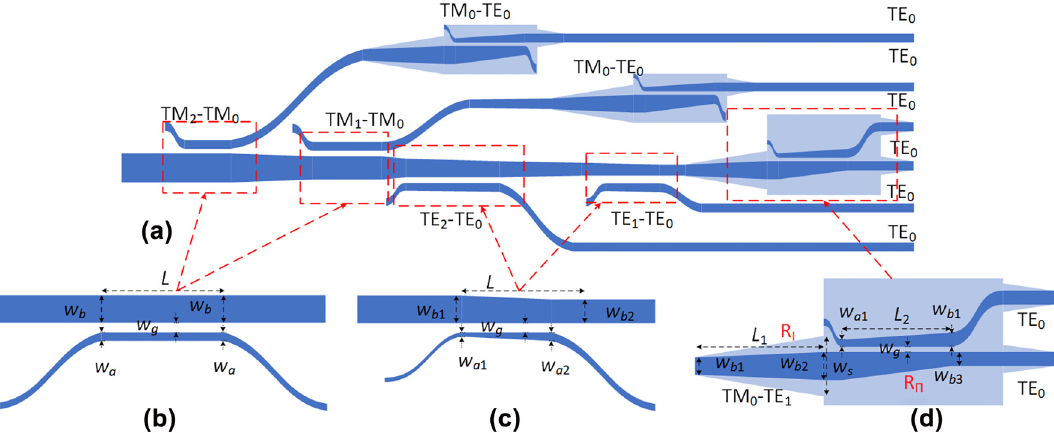
Figure 3: Schematic diagrams of the structures. (a) The mode/polarization (DE) multiplexer; (b) the ADC for TM modes; (c) the asymmetric-adiabatic-coupler for TE modes; (d) the PSR/PR.